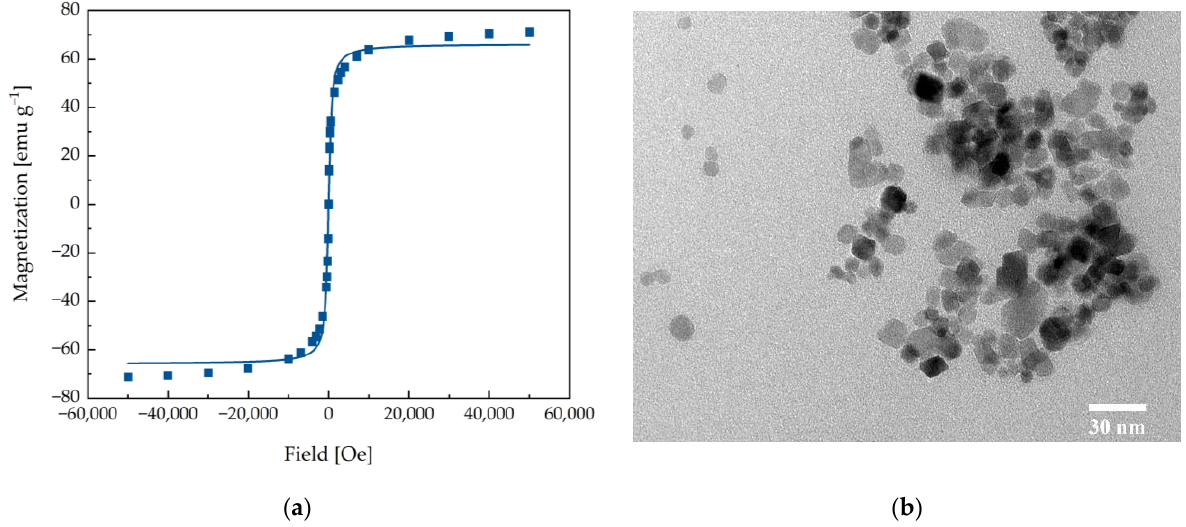
Figure 1. ( a ) Superconducting quantum interference (SQUID) measurement for the bare iron oxide nanoparticles (BIONs) at 300 K with a LangevinMod fit. ( b ) Transmission Electron Microscopy (TEM) image of the BIONs.